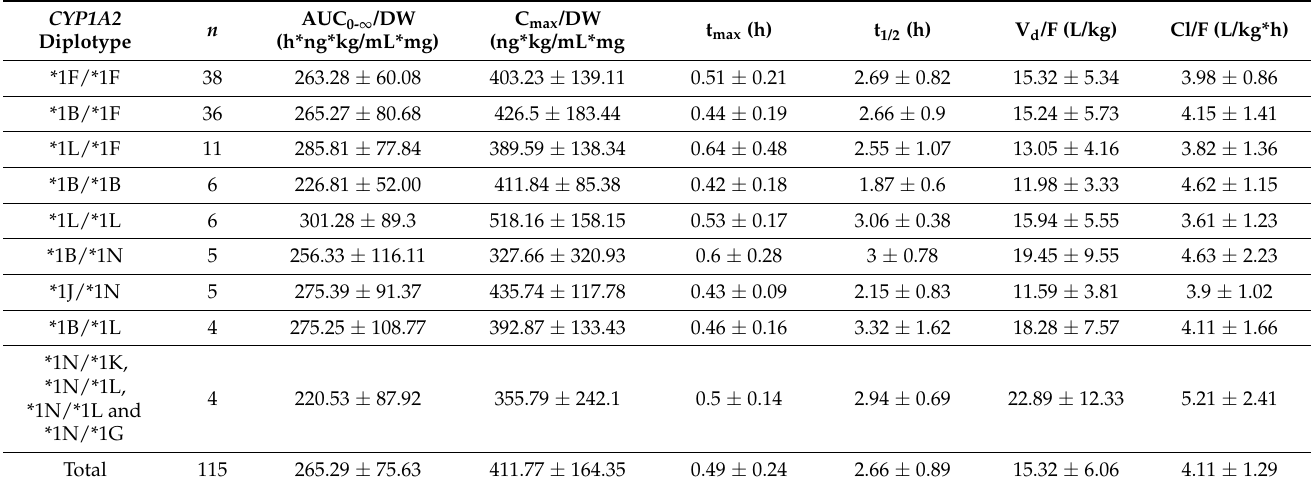
Table 4. Pharmacokinetic parameters of rasagiline according to CYP1A2